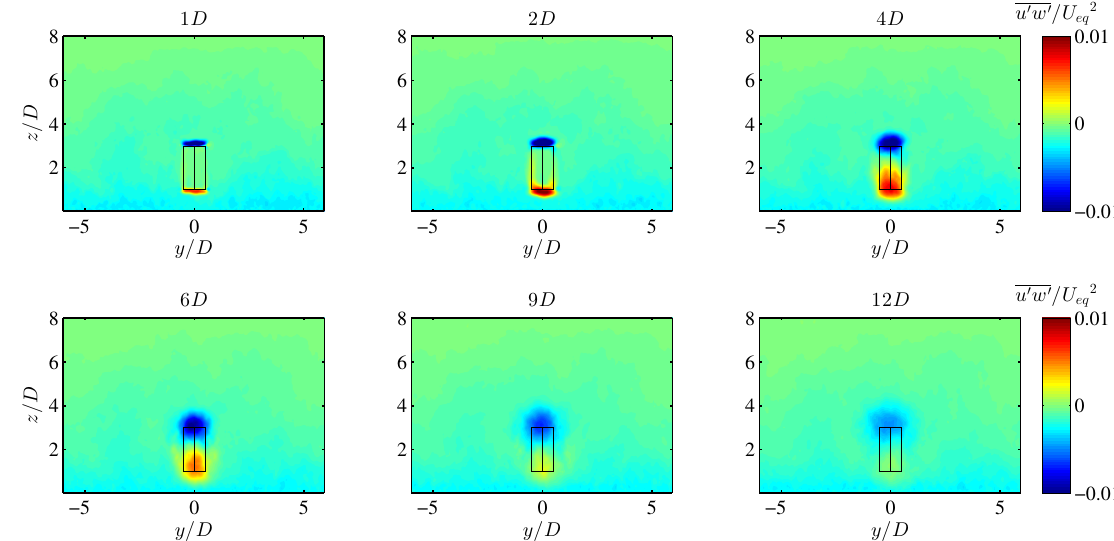
Figure 19. Contour plots of the normalized vertical turbulent flux, u (cid:48) w (cid:48) / U eq 2 , in six different y - z planes at different distances downstream of the center of the